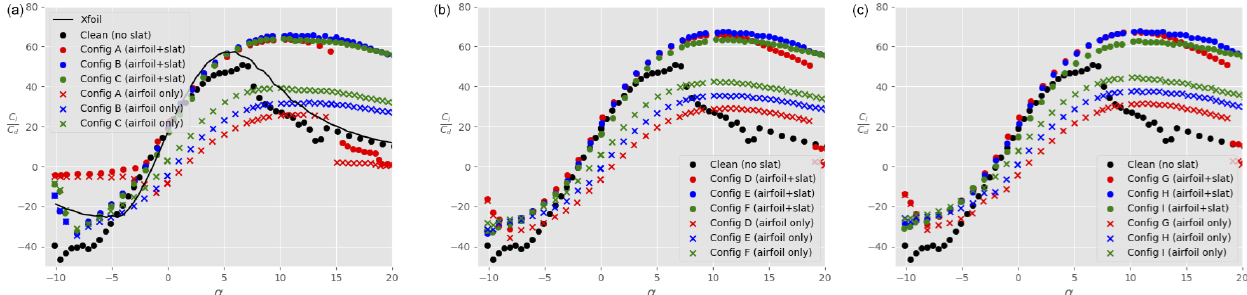
Figure 8. Lift-to-drag ratio C l /C d as a function of the angle of attack α for different slat configurations, a clean main airfoil (i.e. no tripping), and Re = 1 . 5 × 10 6 : h slat /c main = 0 . 02 (a) , h slat /c main = 0 . 03 (b) , and h slat /c main = 0 . 04 (c) . The black data are taken without slat, while the coloured data are in the presence of a slat with β slat = 16 . 4 ◦ (red), β slat = 21 . 4 ◦ (blue), and β slat = 26 . 4 ◦ (green). Furthermore, dots represent the total lift coefficient (main airfoil + slat), whilst the crosses show the lift force on the main airfoil only. The results of Xfoil simulations for the clean main airfoil are shown by the continuous black line in panel (a)